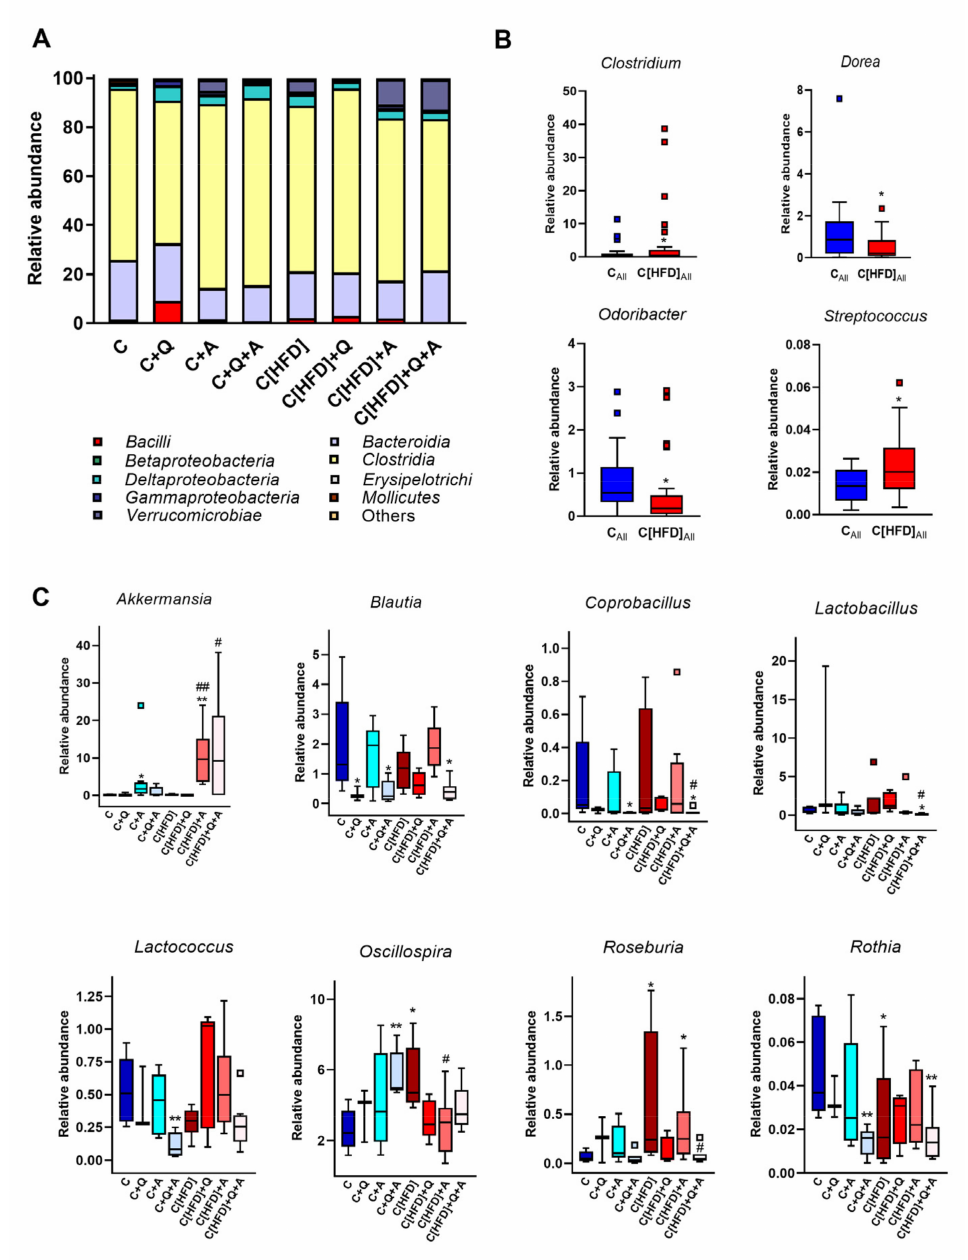
Figure 5. Metagenomic findings in rats after three weeks of dietary intervention, quercetin and A. muciniphila supplementation. ( A ) Relative abundance of the total microbial population at class level. ( B ) Differences in the relative abundance at genus level between control diet-fed or formerly HFD-fed rats independently of other treatments. * p < 0.05 vs. control diet-fed group (C All ). ( C ) Differences in the relative abundance at genus level considering all experimental groups. Statistical analysis was performed using Kruskal–Wallis followed by Mann–Whitney U-test ( p < 0.05). * p < 0.05, ** p < 0.01, vs. C; # p < 0.05, ## p < 0.01 vs.